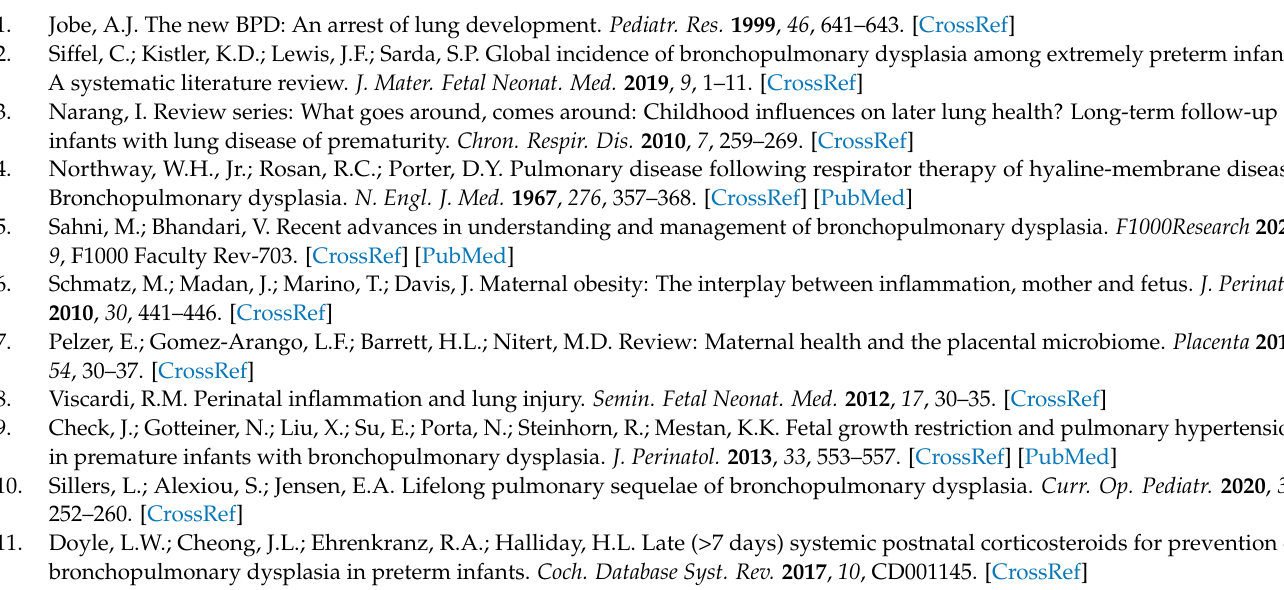
Figure S2: Cellular movement, immune cell trafficking, immunological disease